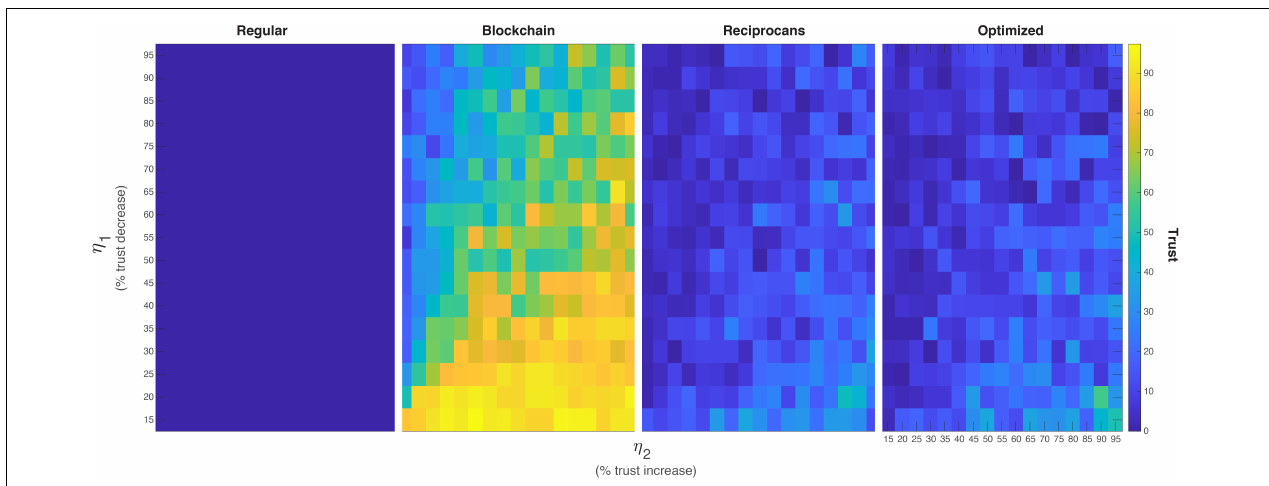
FIGURE 8 | Ultimate trust value in all games for all variables. Each cell corresponds to the final trust value (after 1,000 iterations) in a simulation with a mix of the variables: iT , η 1 , η 2 , and µ . Left: ultimate trust value in the average of 4,913 (17 η 1 × 17 η 2 × 17 iT combinations) of regular games. Second from left: ultimate trust value in 4,913 conditions with regular Blockchain simulation. Second from Right: ultimate trust values in a reciprocans Blockchain condition. Rightmost panel: ultimate trust values in an optimized Blockchain simulation. The upper-left triangle in the “Blockchain,” “Reciprocans” and “Optimized” simulations are nearly same in their value. As these triangles correspond to a more realistic trust scenario (see Figure 2 , left) we suggest that trust is increasing similarly in all conditions (albeit less frequently in the simulations that allow fairness as a variable). In games with “lovers” conditions ( η 2 >> η 1 ) all the trust outcomes are different that the norm, as is often the case with love.